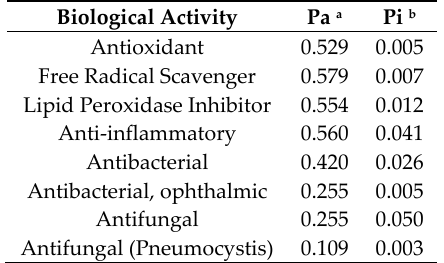
Table 3. Predicted biological activity spectra of the GA on the basis of PASS prediction